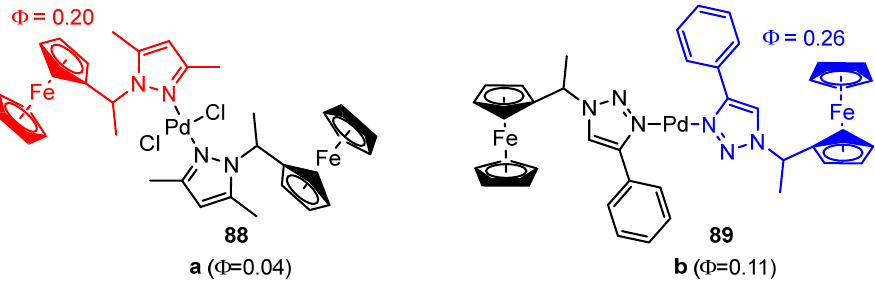
Figure 24. Ferrocenyl pyrazolyl (Red) and ferrocenyl triazolyl (Blue) ligands and their palladium metal complexes ( 88 and 89 ). Adapted from [93].